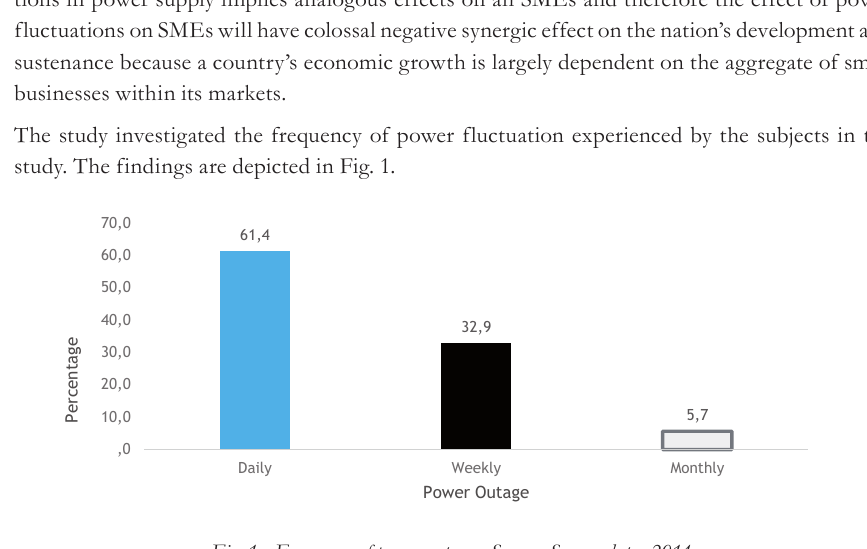
Fig. 1 - Frequency of power outages. Source: Survey data,